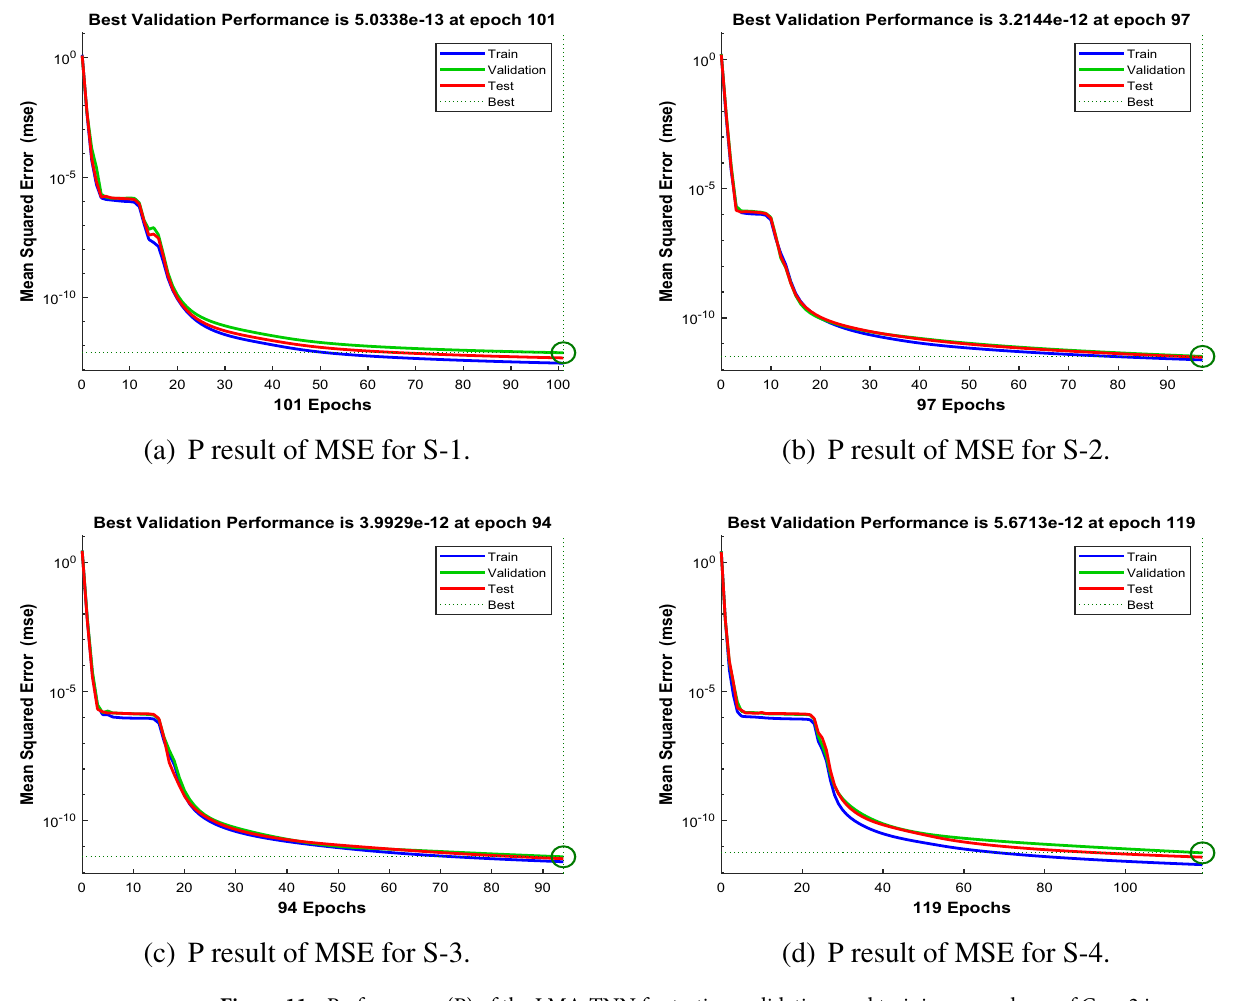
Figure 11. Performance (P) of the LMA-TNN for testing, validation, and training procedures of Case 2 in Vogel’s